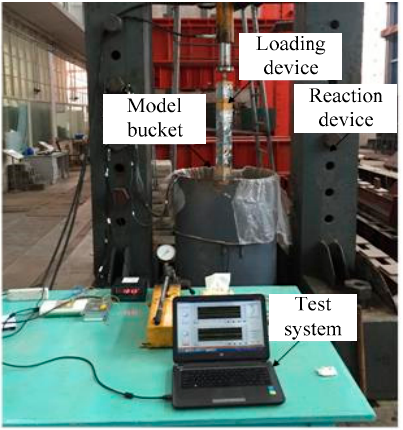
Figure 11. Test device.